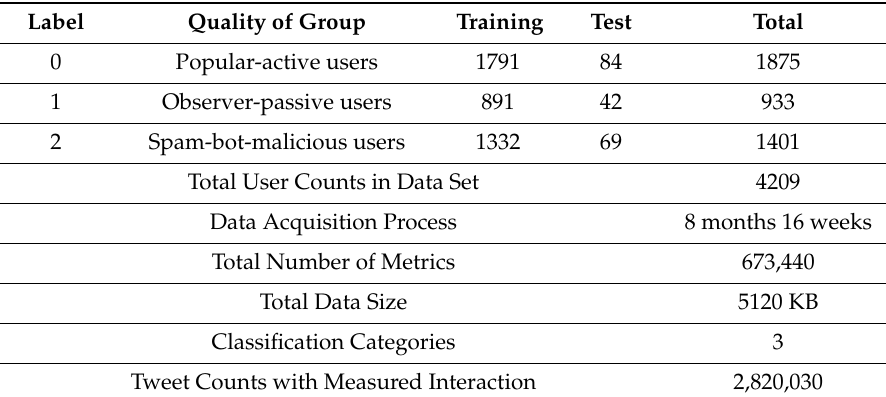
Table 2. Qualities of the data set with label and number of profiles